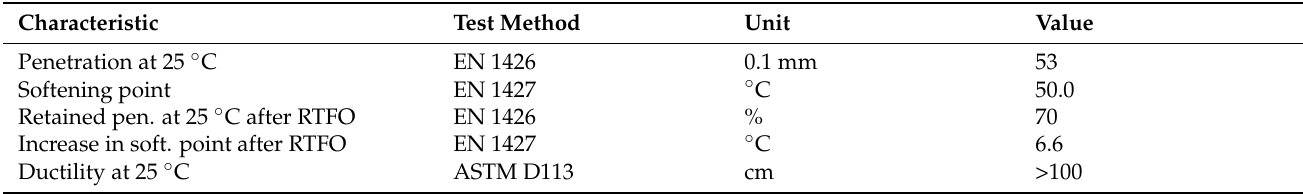
Table 1. Basic characteristics of the selected asphalt